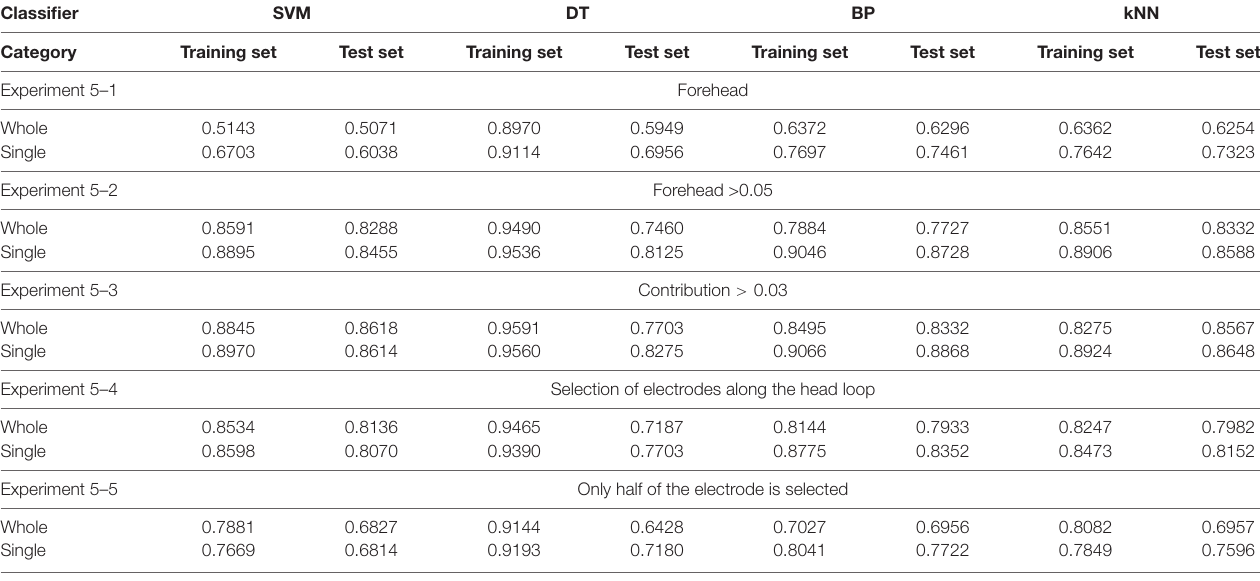
TABLE 7 | The effect of differential entropy characteristics under each electrode combination on emotion classification.